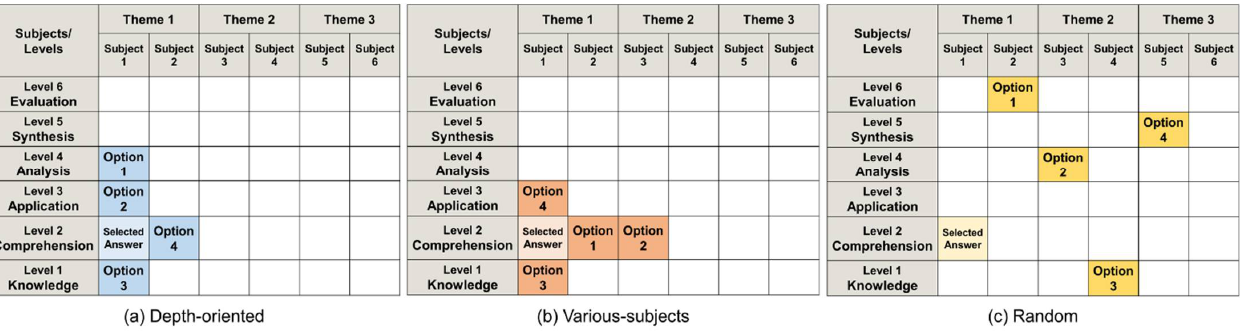
Figure 2. Examples of recommendations presented by the three